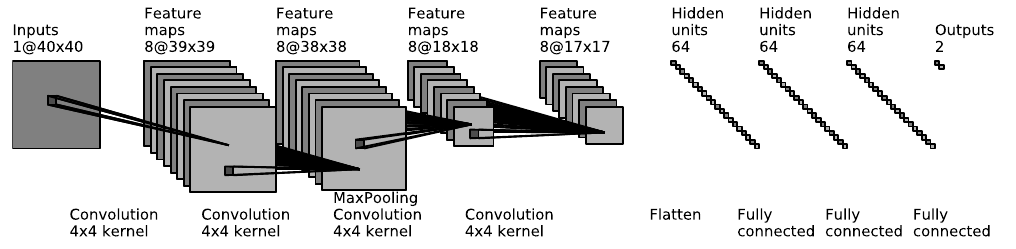
Figure 4 . Architecture 2 of our default networks for fully pre-processed images, de(cid:12)ned in table